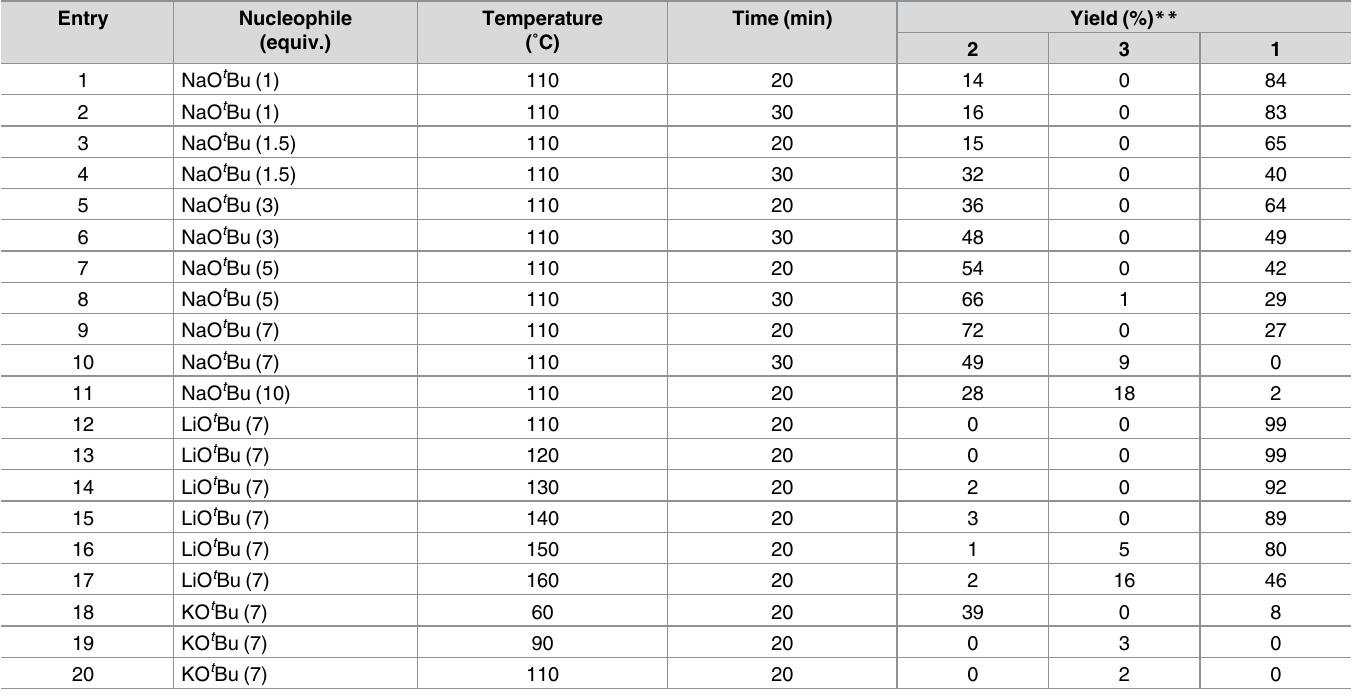
Table 2. Optimization of the amount of nucleophile and the effect of the counterion of t -butoxide.